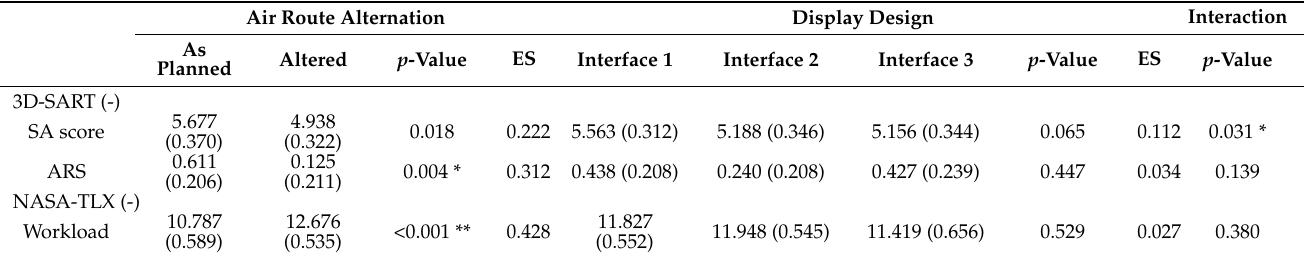
Table 1. ANOVA results for the subjective scale measures (mean (SD)).